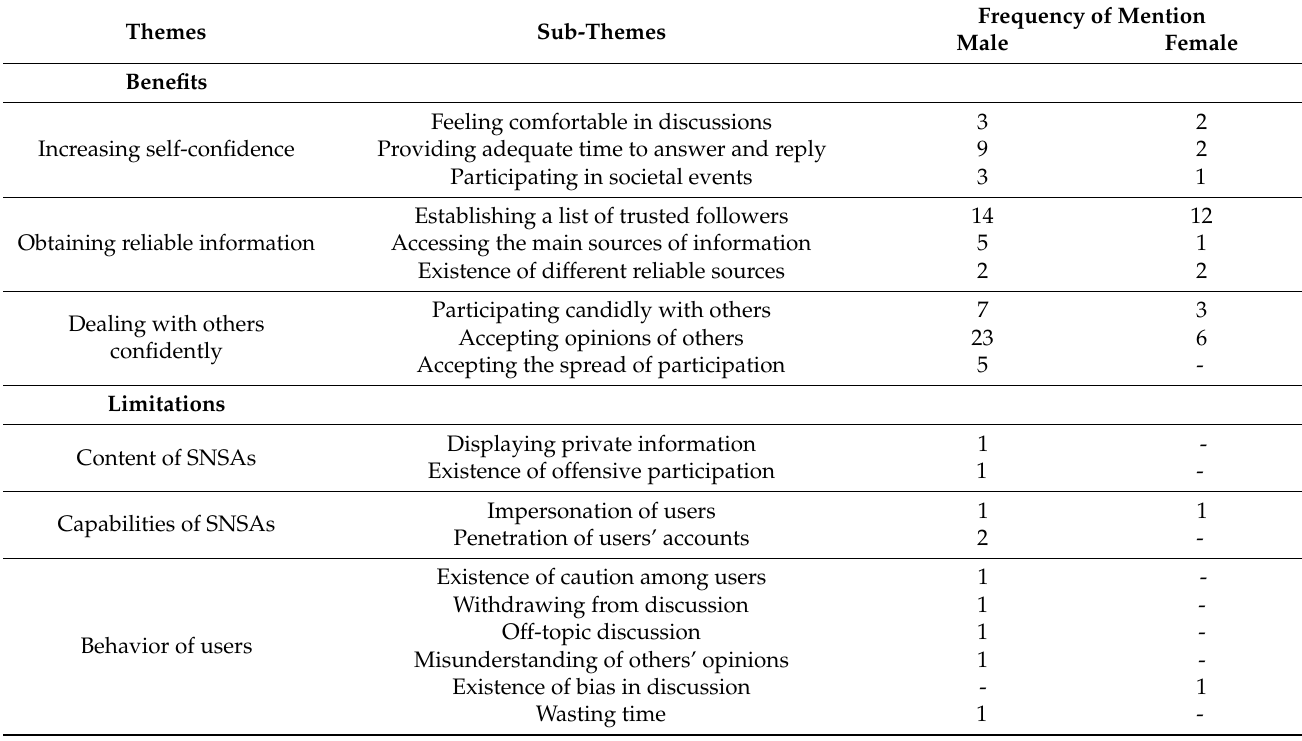
Table 9. Themes relating to SNSAs and social